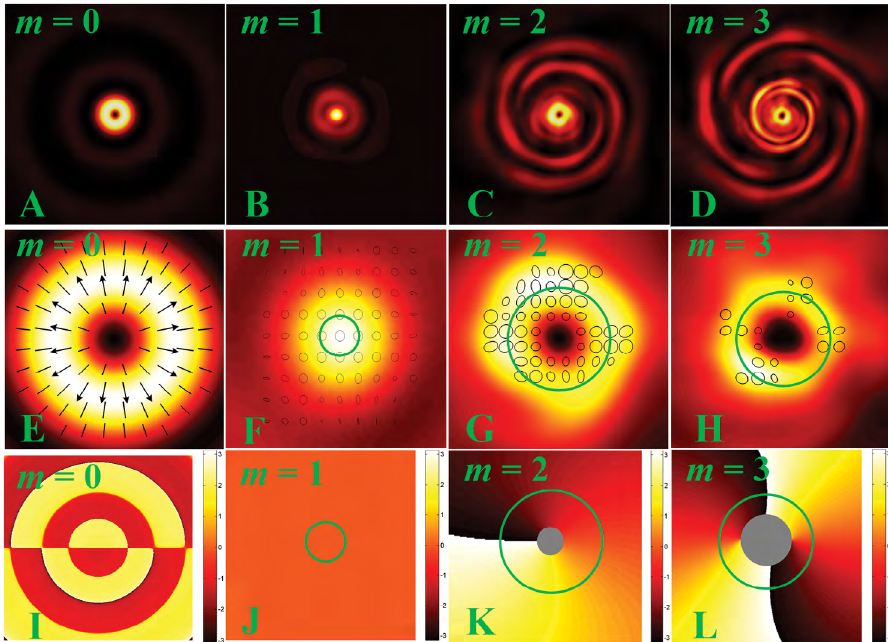
Figure 12 Numerical simulation results for 4-turn spiral structure with different geometric topological charge m . Top panel: intensity distri- bution, middle panel: polarization map superimposed on zoom-in intensity distribution, bottom panel: phase distribution of E lobe. Adapted from Ref. [35].